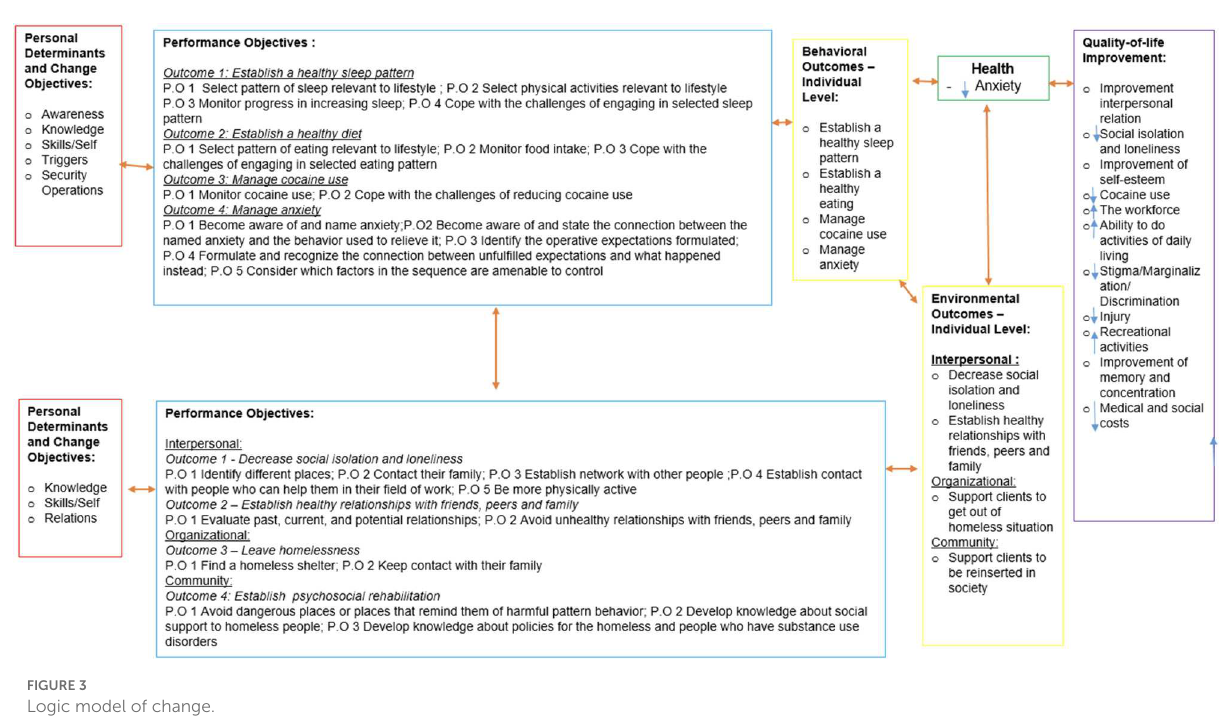
FIGURE3 Logic model of